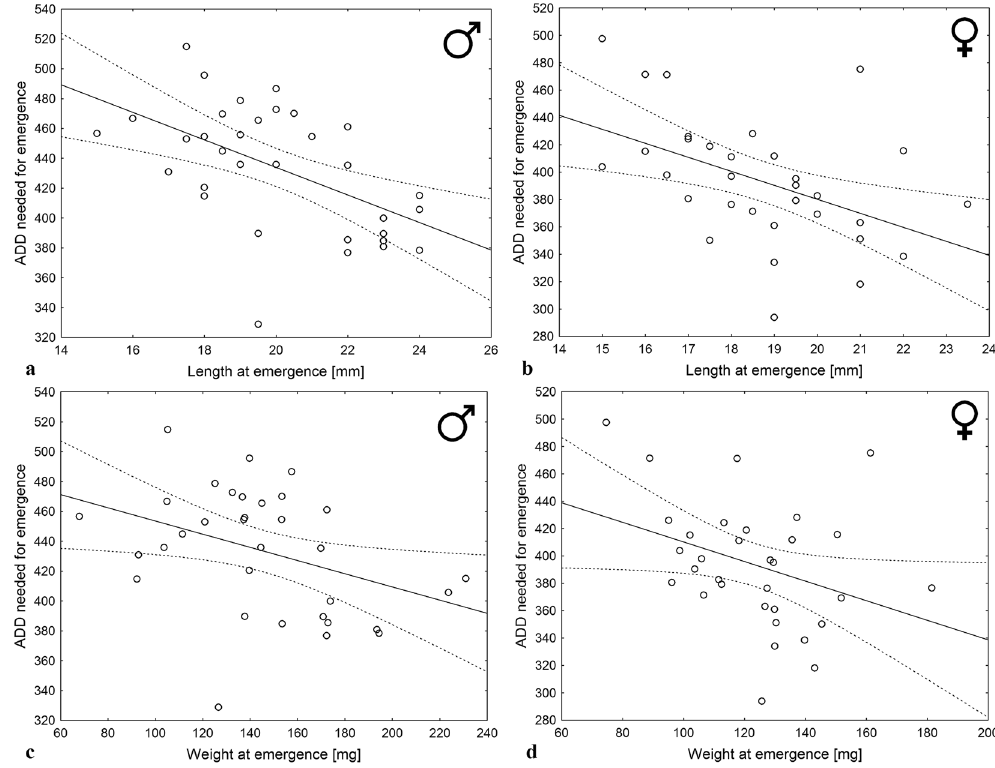
Figure 2. The relationship between adult C. maxillosus length ( a , b ) or weight ( c , d ) at emergence in male ( a , c ) or female ( b , d ) sample and thermal summation values needed for emergence (ADD over 11.43 °C for males and over 11.81 °C for females). Solid line – linear regression model, dotted lines – confidence limits.